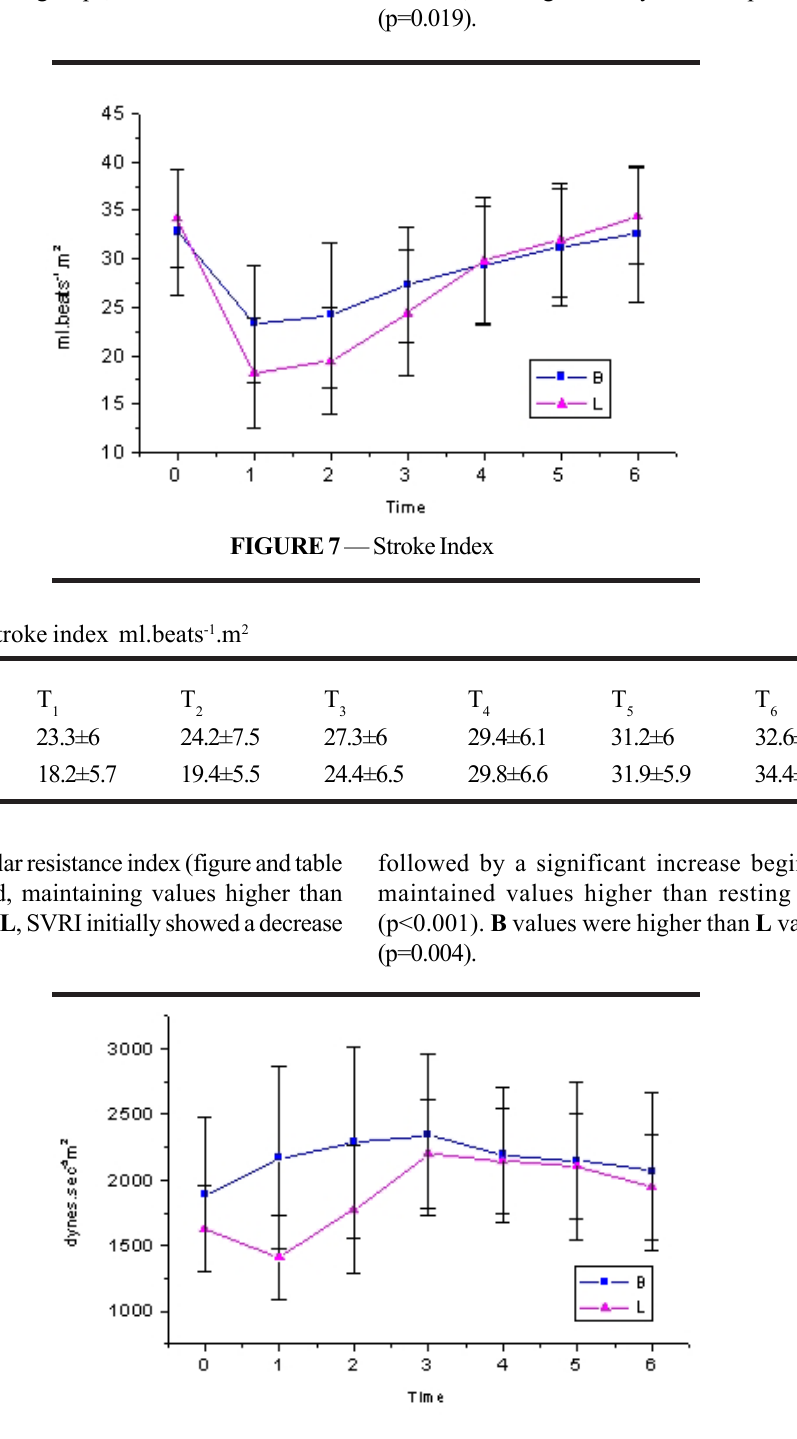
FIGURE 8 — Systemic Vascular Resistance